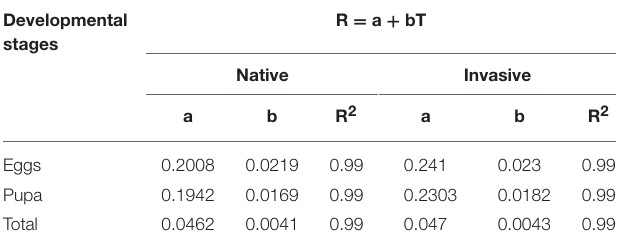
TABLE 6 | Thermal constants at seven constant temperatures in species invasive to the Nearctic ( C. septempunctata, C. undecimpunctata, H. axyridis, H. variegata, P. quatuordecimpunctata), and native to the Nearctic (A. bipunctata, C. quatuordeciguttata, C. sulphurea, C. californica, C. novemnotata, C. transversoguttata, C. trifasciata, C. maculata, C. polita, H. parenthesis, H. convergens, H. quinquesignata, H. sinuata, Lemnia biplagiata, O. v-nigrum ).